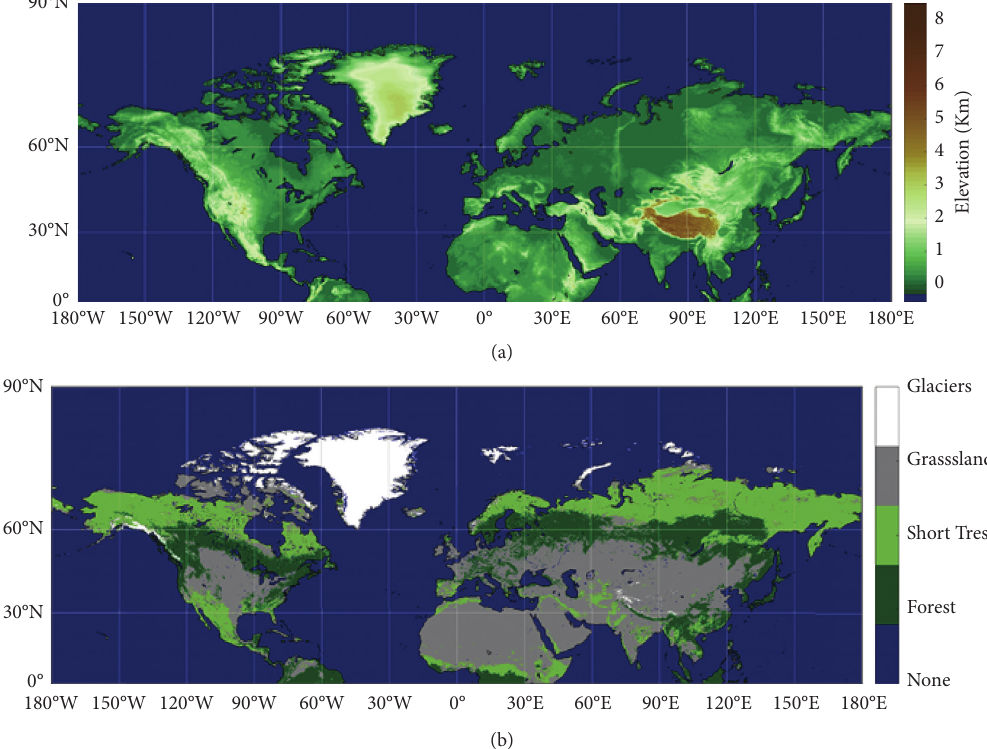
Figure 4: (a) GTOPO30 elevation and (b) MODIS land cover category (forest, short trees, and grassland classes).